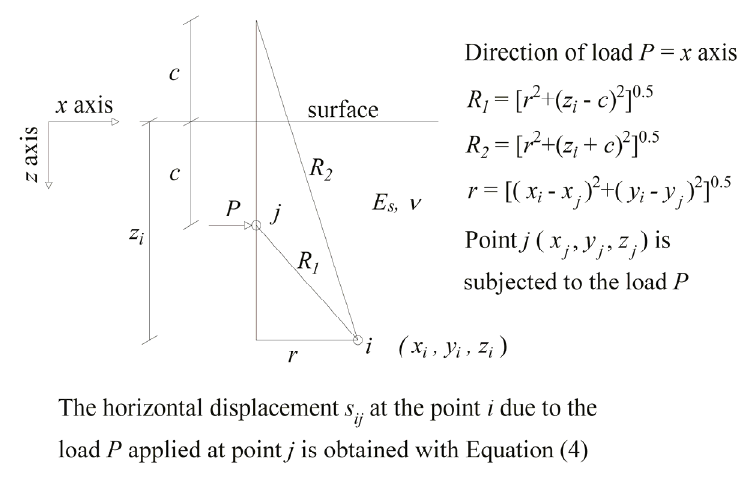
Figure 4. Mindlin solution scheme.